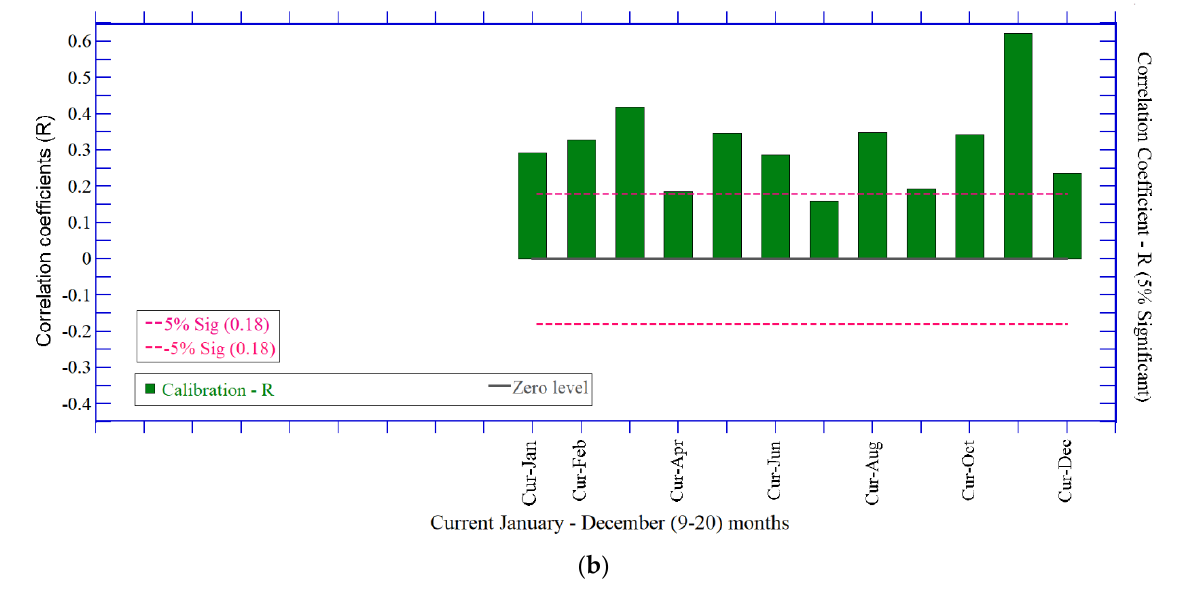
Figure 6. ( a ) Correlation coefficient between NB − CRNS and monthly mean temperatures (NBGridTEM-MM-6) for the period of 1901 – 2016. ( b ) Correlation coefficients between NB − CRNS and monthly mean temperatures (NBGridTEM-MM-6) for the period of 1961 – 2016. The horizontal dashed lines show 5% significant threshold values [70].